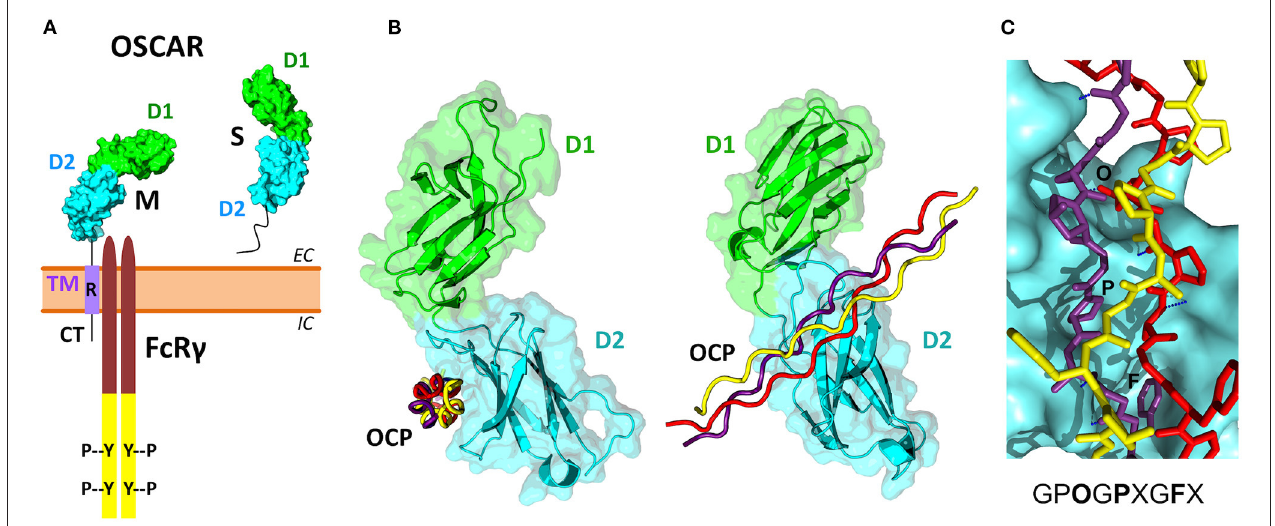
FIGURE 3 | OSCAR domain structure and its association with FcR γ and collagen ligands. (A) Several membrane-associated (M) and soluble (S) isoforms have been reported for human OSCAR ( Table 2 ). The M isoforms contain two extracellular Ig-like domains D1 (green) and D2 (cyan), a single transmembrane region TM (purple), and a short cytoplasmic tail CT. An arginine residue (R) within the TM region links OSCAR with the FcR γ adaptor. The S isoforms result from alternative splicing of the human OSCAR gene that removes the TM region. (B) Two views of the crystal structure of the OSCAR ectodomain D1-D2 in complex with an OSCAR-binding collagen-like peptide (OCP) (Haywood et al., 2016; Zhou et al., 2016). D1 and D2 are shown as ribbon and surface diagrams, and the three OCP chains are shown as red, yellow and purple ropes. (C) Details of the OCP bound to the primary binding site on D2. The consensus OSCAR-binding sequence is shown. Two of the three peptide chains bind tightly to the D2 surface, with several hydrogen bonds (blue dotted lines) and side chains of several residues (O, P, F) fitting D2 surface pockets.